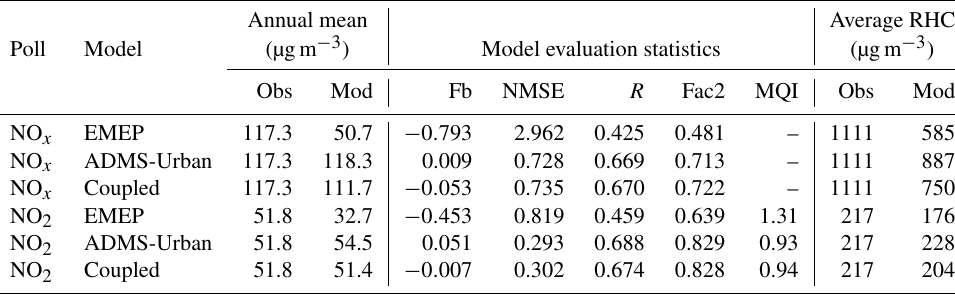
Table 4. NO x and NO 2 model evaluation statistics calculated at 42 sites for regional (EMEP), local (ADMS-Urban), and coupled modelled and measured hourly concentrations. Fb – fractional bias in annual average, ideal value 0.0; NMSE – normalized mean square error in hourly concentrations, ideal value 0.0; R – correlation coefficient of hourly concentrations, ideal value 1.0; Fac2 – fraction of hourly modelled concentrations within a factor of 2 of observed, ideal value 1.0; MQI – model quality indicator (annual), target value ≤ 1 . 0; average RHC – average over all sites of robust highest concentration calculated for each site (hourly). Note that MQI is not defined for NO x .